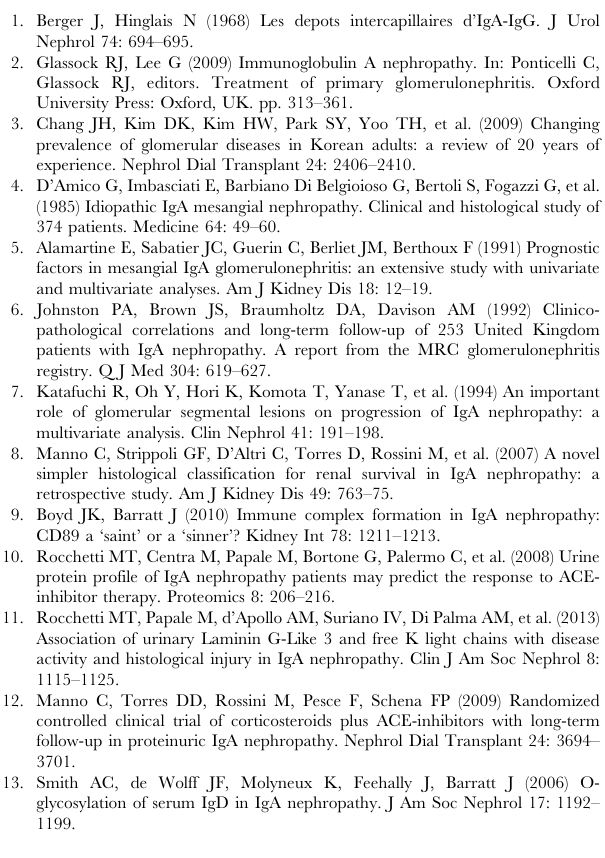
Figure S1 Total and active bacteria found in feces of subjects. Relative abundance (%) of total (16S rDNA) (A) and